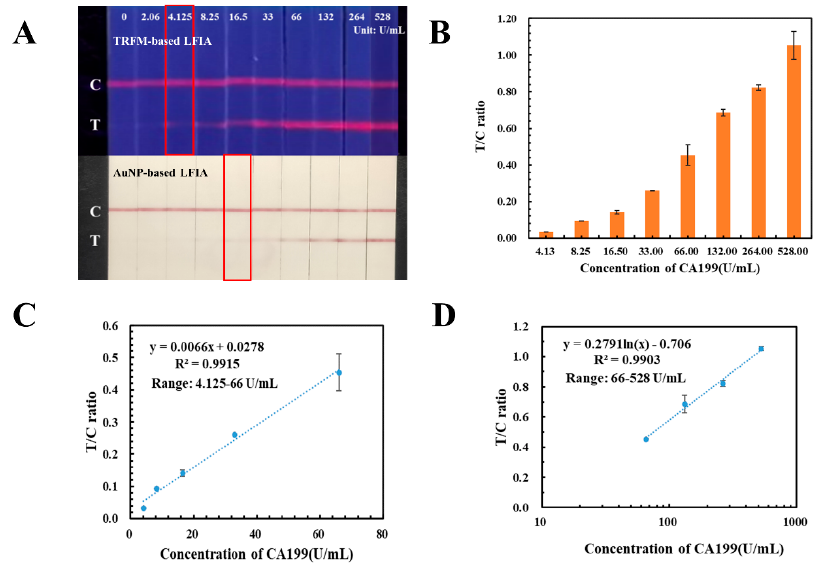
Figure 5. Performances of the AuNP-based LFIA for CA199. ( A ) Comparison between TRFM-based LFIA and AuNP-based LFIA in testing CA199 from 0.00 U/mL to 528.0 U/mL. ( B ) T/C ratio of CA199 detected by the AuNP-based LFIA. ( C , D ) Calibration curves for the determination of